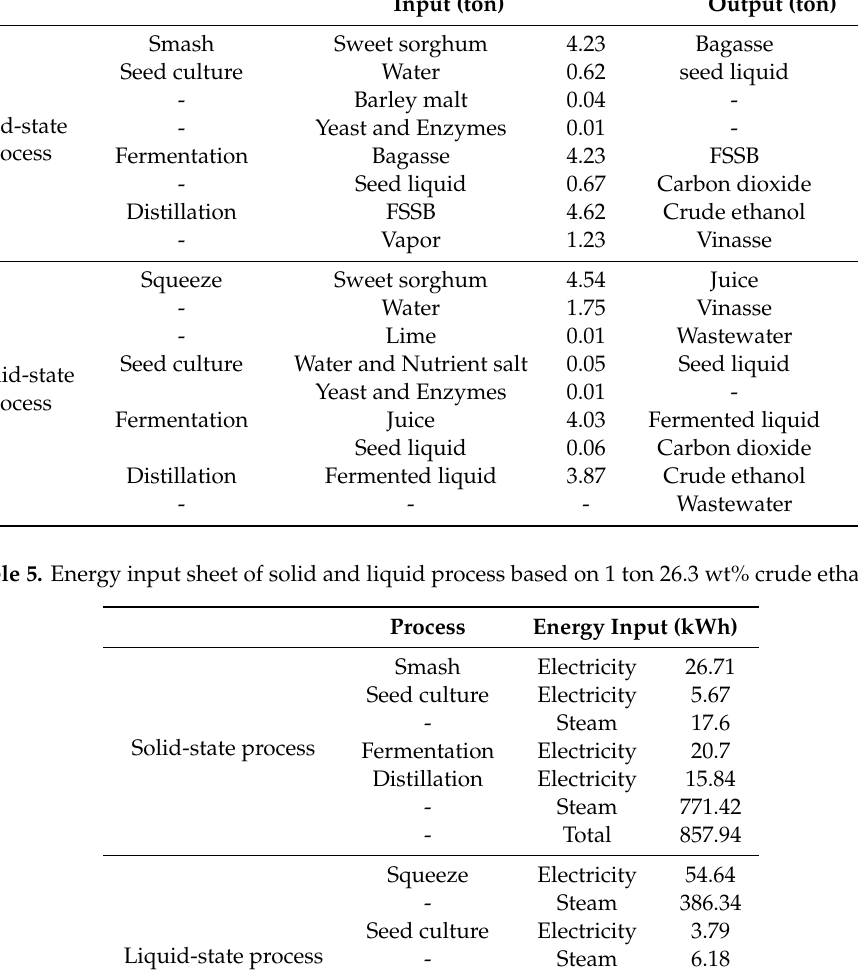
Table 4. Materials balance sheet of solid and liquid process based on 1 ton 26.3 wt% crude ethanol. Process